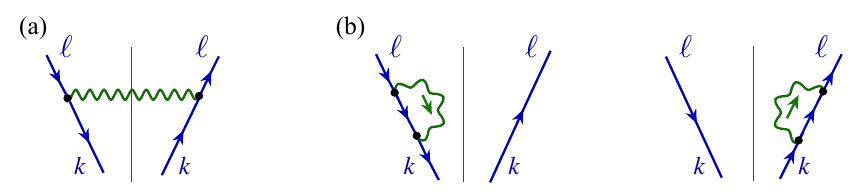
Figure 7 . Examples of (a) real and (b) virtual QED diagrams contributing to the NLO lepton distribution f (1) e/e